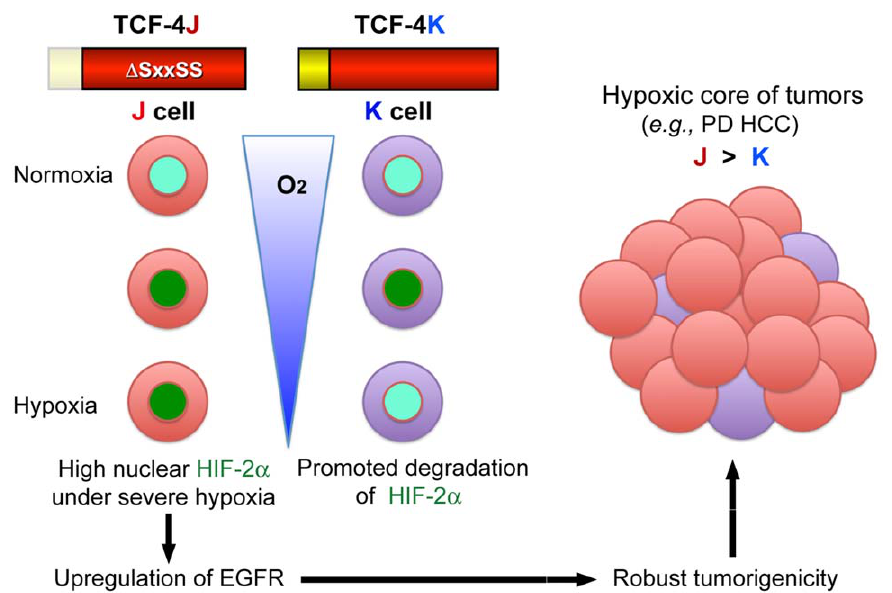
Figure 7. Proposed role(s) of TCF-4J and K isoforms during hepatic oncogenesis. Loss of SxxSS motif in TCF-4J ( D SxxSS) supports high level nuclear expression of HIF-2 a with increasing degrees of hypoxia. This phenomenon upregulates and activates the EGFR signaling cascade including downstream genes that inhibit apoptosis to promote tumor development. In contrast, the TCF-4K isoform containing the SxxS motif degrades HIF-2 a under increasing hypoxic conditions via the ubiquitination pathway and, therefore, downregulates HIF-2 a mediated gene expression. The net effect is to inhibit the characteristics of a more aggressive malignant phenotype. Thus, TCF-4 isoform expression may play an important role in the molecular pathogenesis of poorly differentiated HCC where severe hypoxia is likely to occur and particularly when TCF-4 isoforms that lack a regulatory SxxSS motif are expressed.